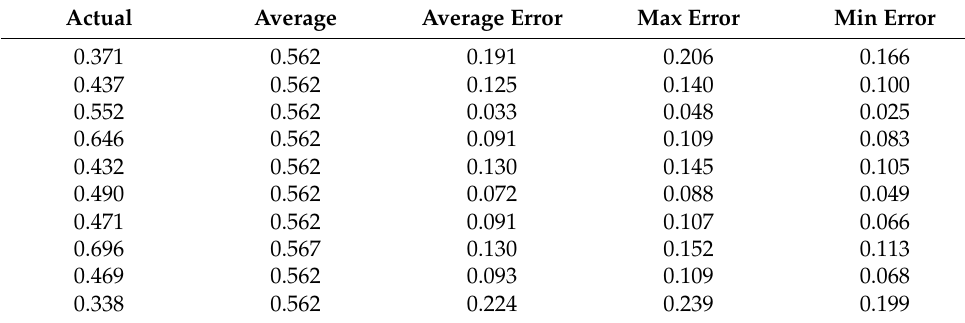
Table A204. Set 3, trials 31–40 data (average actual PR values).